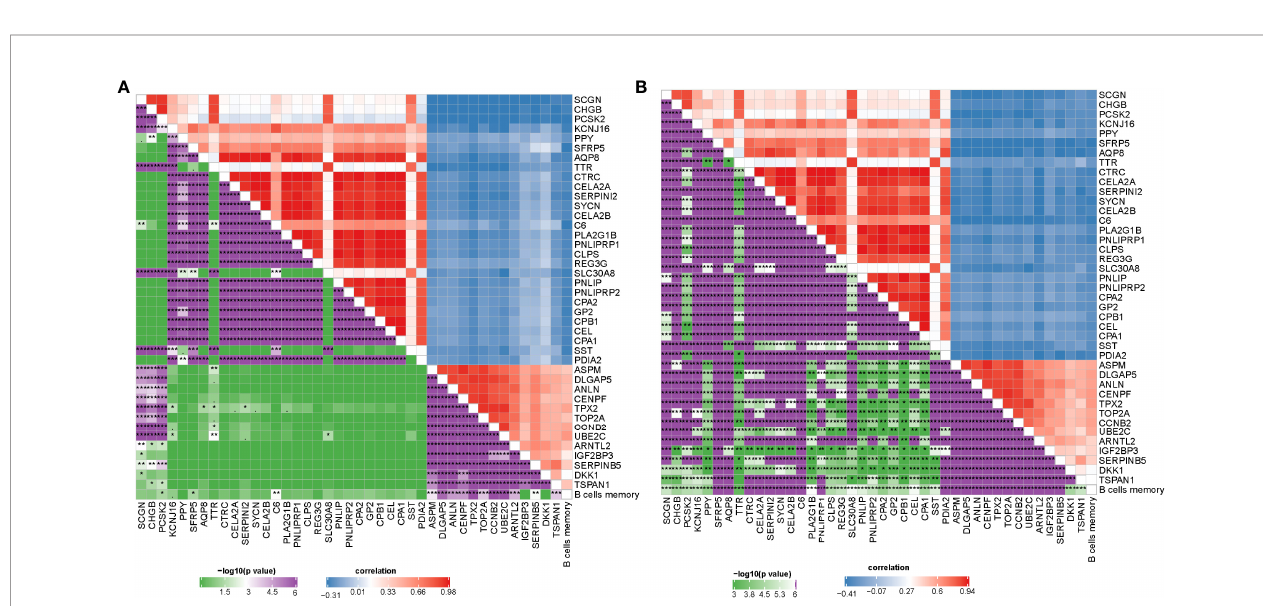
FIGURE 6 | Pearson correlation analysis between MBCs and 41 key DEGs in TCGA-PAAD (A) and GEO (B) cohorts. Blue indicates negative correlation and red indicates positive correlation. * P < 0.05, ** P < 0.01, and *** P <